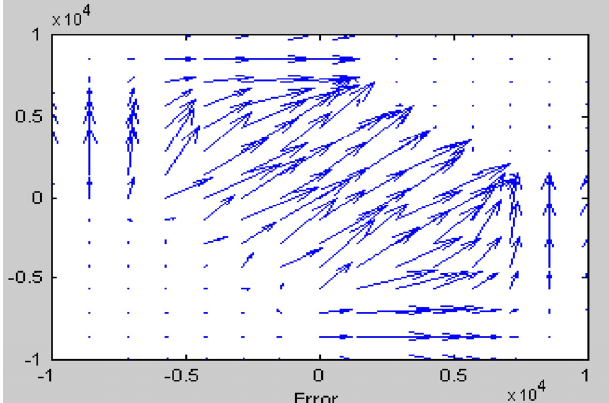
Figure A6. Quiver.